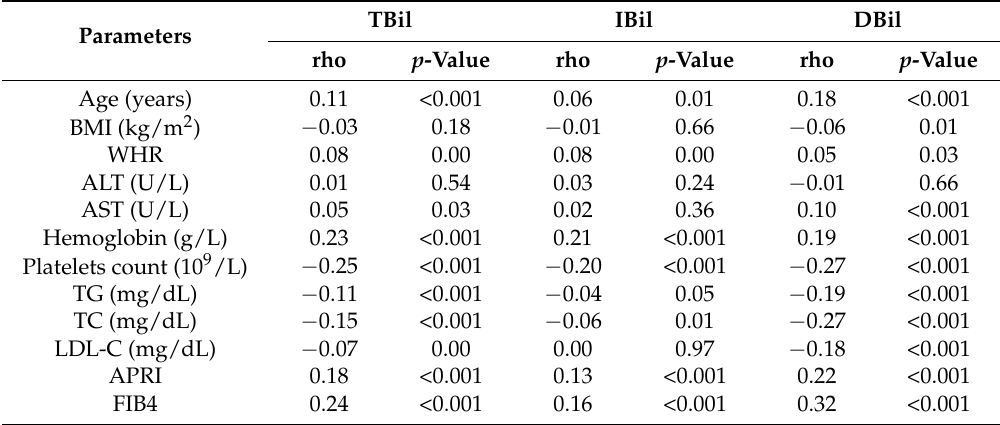
Table 2. Univariate associations between bilirubin and demographic, biochemical parameters and non-invasive liver fibrosis indices in participants with HBV infection.